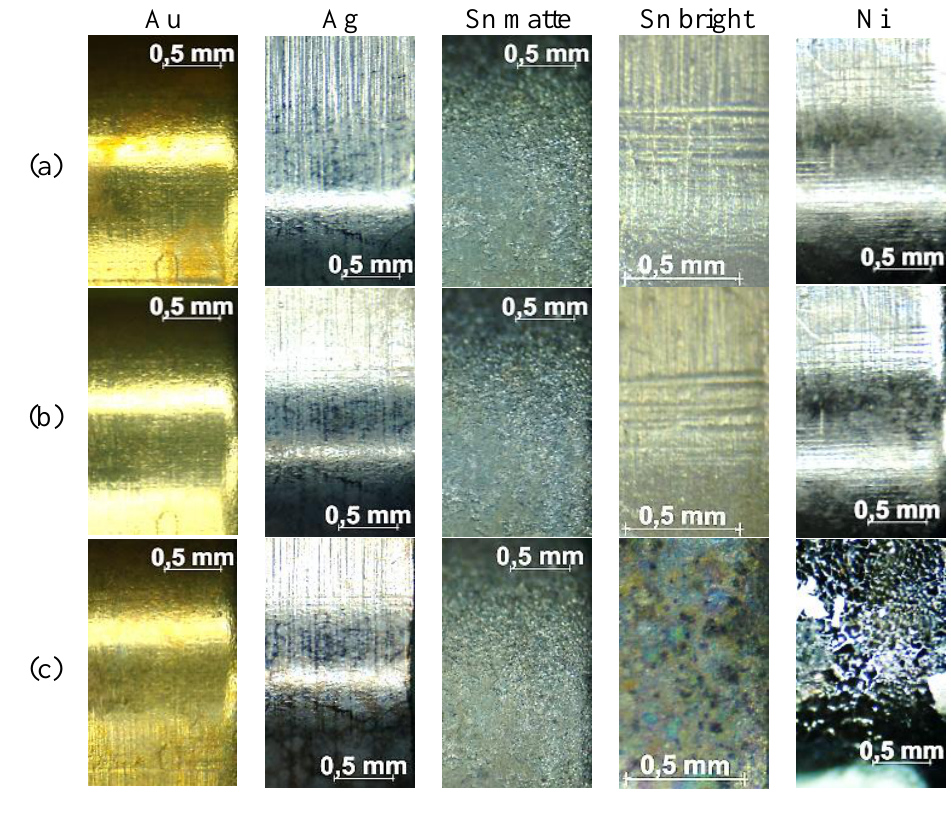
Figure 16. ( a ) Surfaces of different coating materials before; ( b ) after the first cycle test; and ( c ) after the second cycle test of